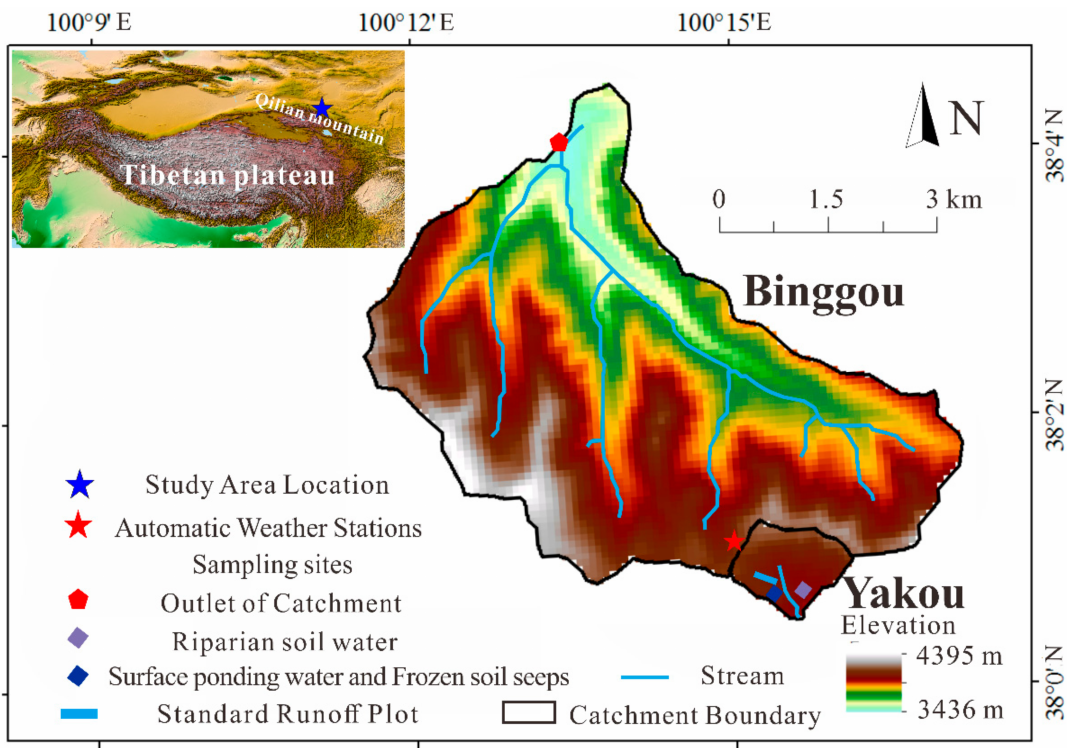
Figure 1. Location and topography of the Binggou catchment with observing and sampling location. The Binggou catchment is underlaid by discontinuous permafrost and continuous permafrost. The distribution of discontinuous permafrost and continuous permafrost varies with altitude: the lower limit of continuous permafrost is ~4000 m a.s.l. and discontinuous permafrost is distributed from 3436 to 4000 m a.s.l. The initial thawing of surface